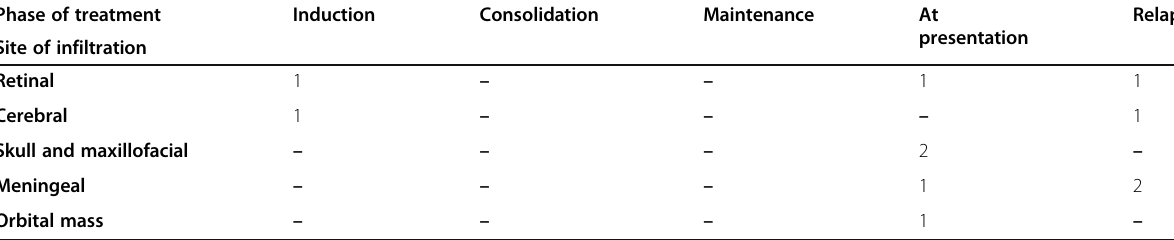
Relapse presentation